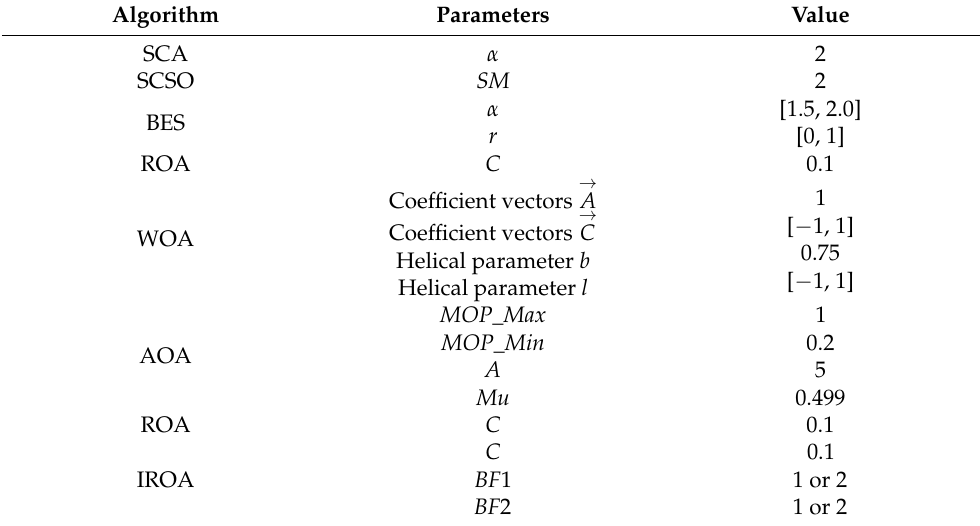
Table 1. Parameter design of each